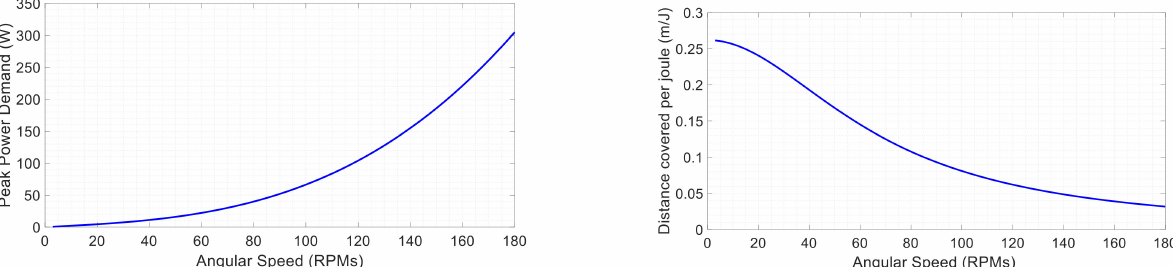
Figure 20. Peak power demand ( left ), and horizontal distance covered per joule consumed ( right ) when m = 1 kg, r = 0.2 m and varying angular